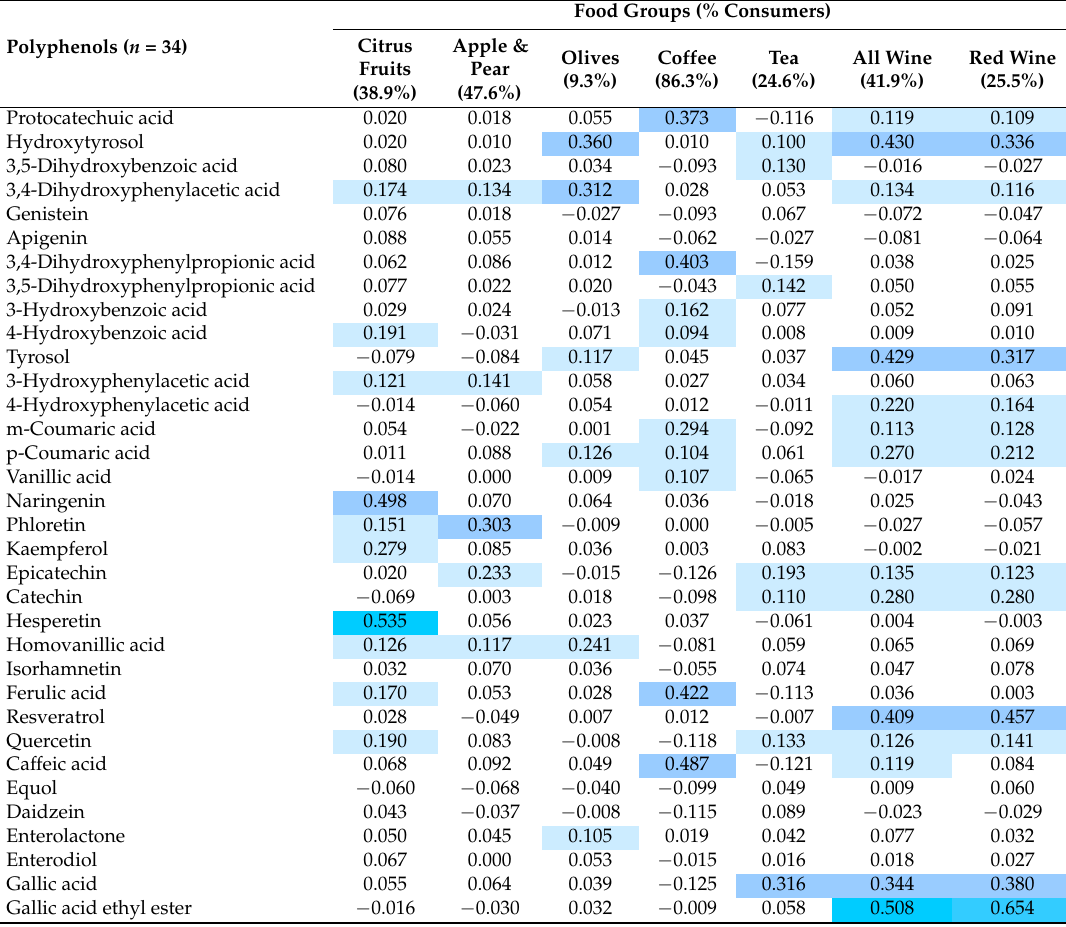
Table 2. Correlation coefficients a between urinary polyphenols and intakes of polyphenol-rich foods from 24-HDR among total subjects ( n =